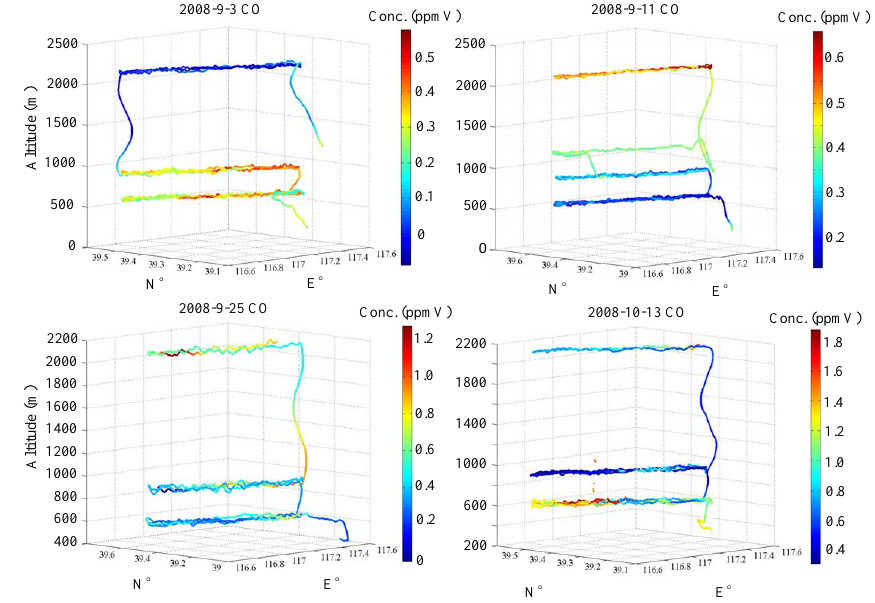
Fig. 7. Variation of CO concentration at different heights for different flights.